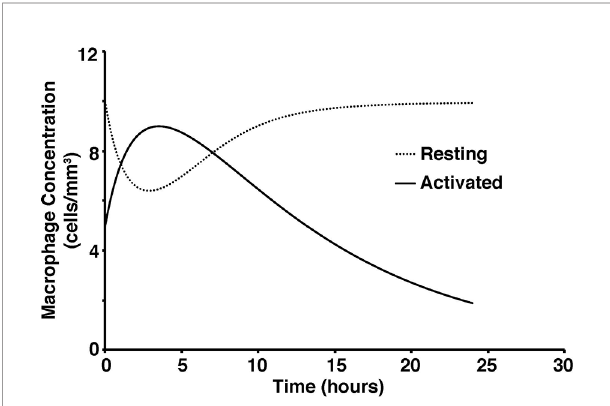
FIGURE 3 | S. aureus average cell concentration in the tissue with and without immune response over a 24-hour period.